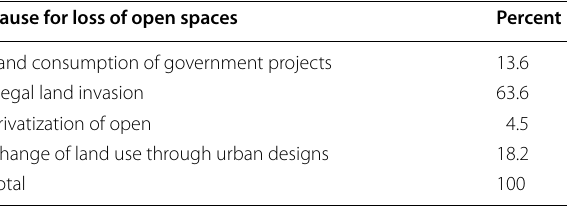
Table 5 Cause for the loss of open spaces at Kebena riverside (N 69) = Cause for loss of open spaces